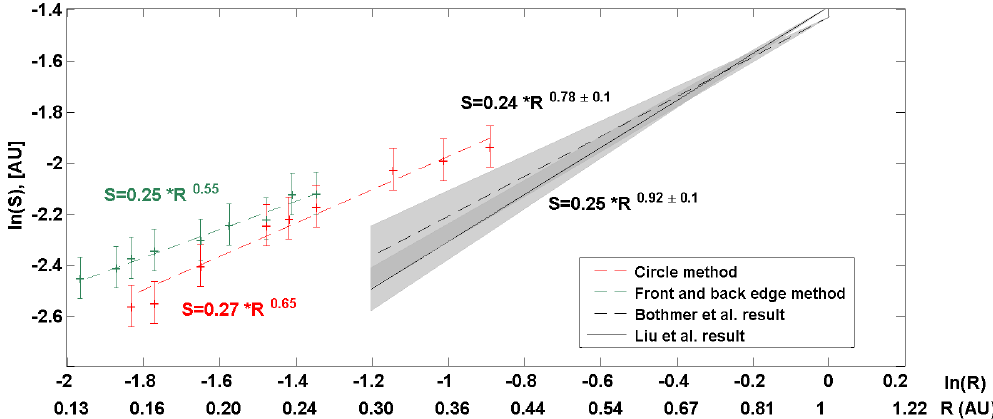
Fig. 6. A log-log plot showing the relationship between CME radial size, S, and heliocentric distance, R. The circle and front-rear edge method are compared to published statistical results in the literature from in situ observations. The grey shaded regions include the errors of the best fit